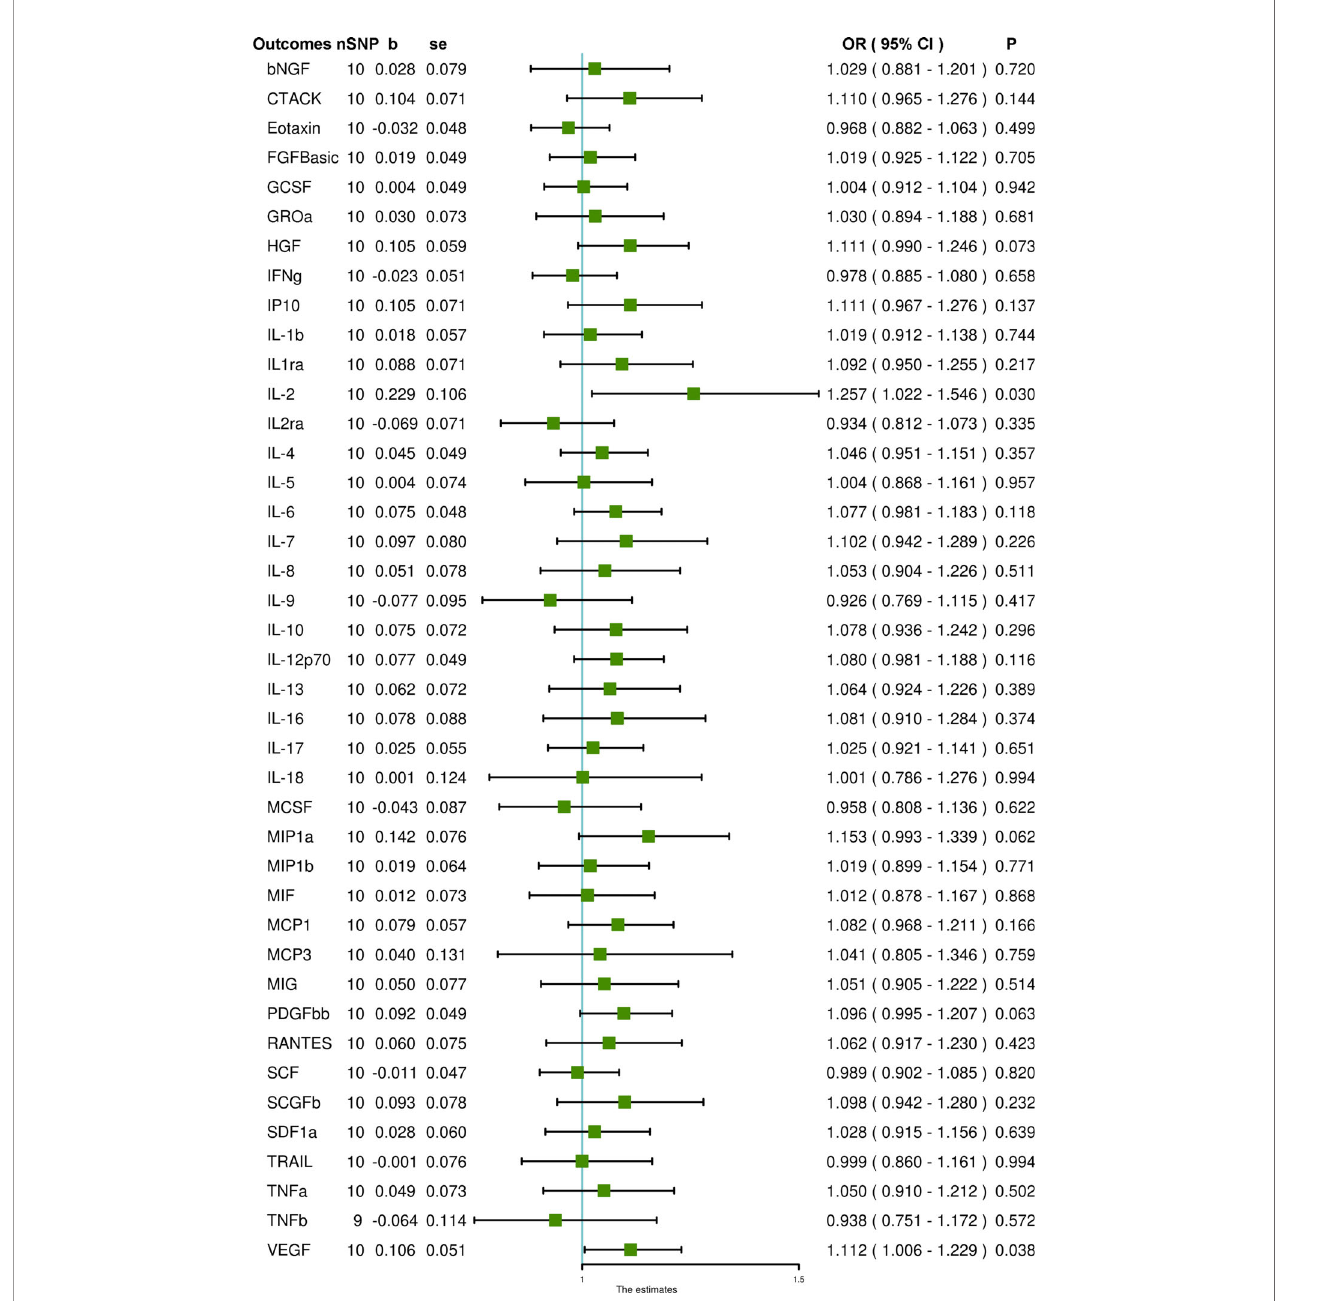
FIGURE 3 | The association of PCOS with systemic in fl ammatory regulators using Mendelian randomization with SNPs reaching P < 5 × 10 – 8 : the inverse-variance weighted (IVW) method was applied as the primary method for MR analysis. SNP, single nucleotide polymorphism; b, beta coef fi cient; se, standard error; OR, odds ratio; CI, con fi dence interval; MR-PRESSO, Mendelian randomization pleiotropy residual sum and outlier; bNGF, beta-nerve growth factor; CTACK, cutaneous T-cell attracting chemokine; FGFBasic, fi broblast growth factor basic; GCSF, granulocyte-colony stimulating factor; GROa, growth-regulated protein alpha; HGF, hepatocyte growth factor; IFNg, interferon gamma; IP10, interferon gamma-induced protein 10; IL-1b, interleukin-1-beta; IL1ra, interleukin-1-receptor antagonist; IL- 2, interleukin-2; IL2ra, interleukin-2 receptor antagonist; IL-4, interleukin-4; IL-5, interleukin-5; IL-6, interleukin-6; IL-7, interleukin-7; IL-8, interleukin-8; IL-9, interleukin-9; IL-10, interleukin-10; IL-12p70, interleukin-12p70; IL-13, interleukin-13; IL-16, interleukin-16; IL-17, interleukin-17; IL-18, interleukin-18; MCSF, macrophage colony stimulating factor; MIP1a, macrophage in fl ammatory protein 1a; MIP1b, macrophage in fl ammatory protein 1b; MIF, macrophage migration inhibitory factor; MCP1, monocyte chemoattractant protein-1; MCP3, monocyte chemoattractant protein-3; MIG, monokine induced by gamma interferon; PDGFbb, platelet-derived growth factor BB; RANTES, regulated on activation, normal T cell expressed and secreted; SCF, stem cell factor; SCGFb, stem cell growth factor beta; SDF1a, stromal-cell-derived factor 1 alpha; TRAIL, TNF-related apoptosis-inducing ligand; TNFa, tumor necrosis factor alpha; TNFb, tumor necrosis factor beta; VEGF, vascular endothelial growth factor.